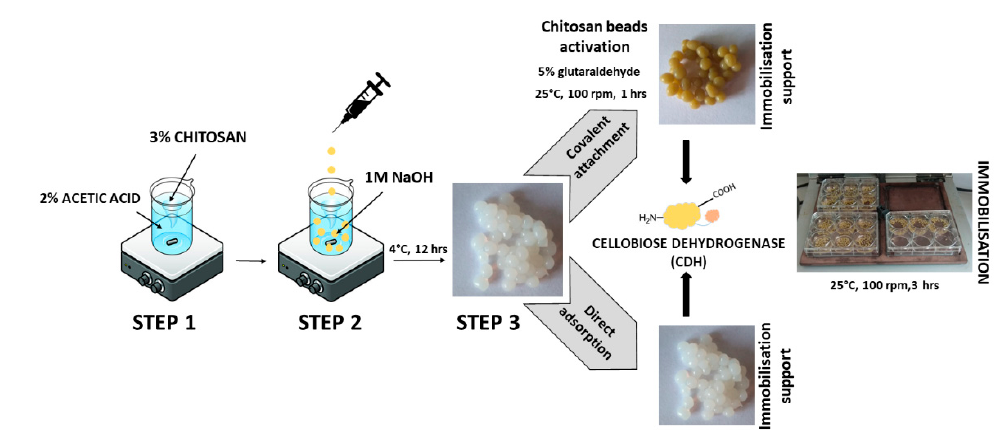
Figure 7. Steps in the immobilization of cellobiose dehydrogenase on chitosan beads.